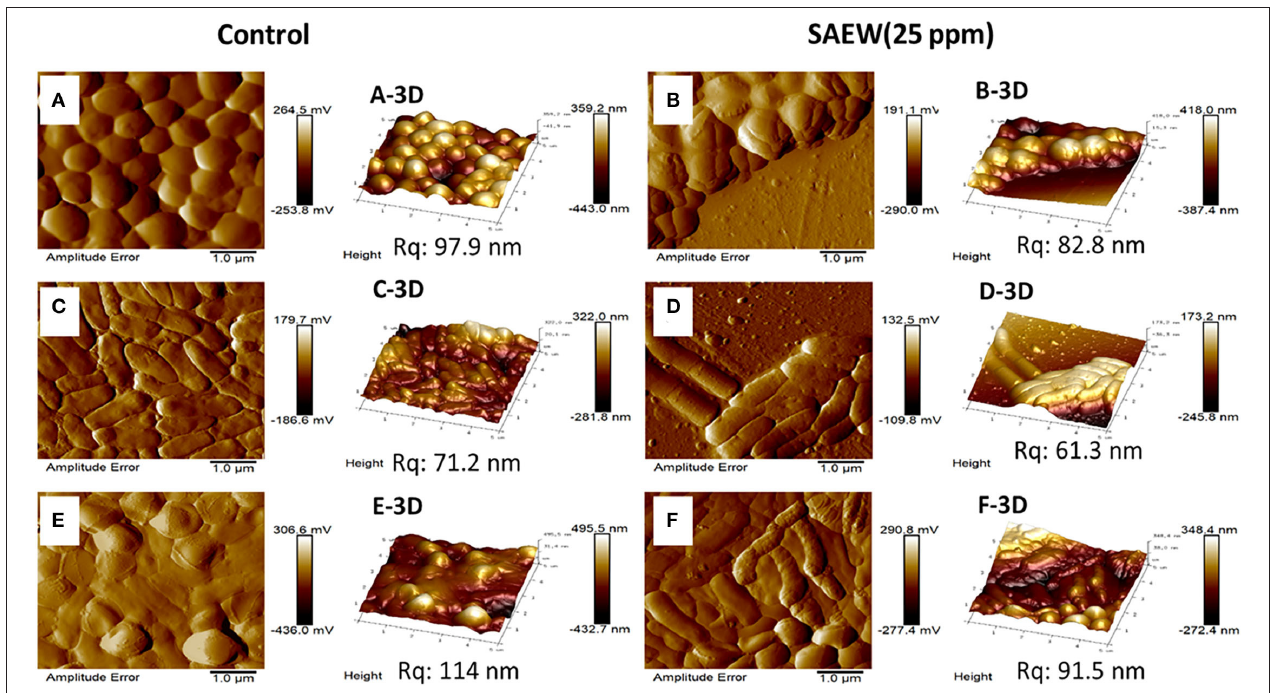
FIGURE 5 | Atomic force microscopy images of the changes in the spatial structures of the single S. aureus , L. monocytogenes Scott A, and mixed-species biofilms under SAEW treatment. Control group [ (A) S. aureus , (C) L. monocytogenes Scott A, (E) mixed-species biofilms] and treatment group [ (B) S. aureus , (D) L. monocytogenes Scott A, (F) mixed-species biofilms]. Scale bar = 1.0 µ m; Rq, root mean square